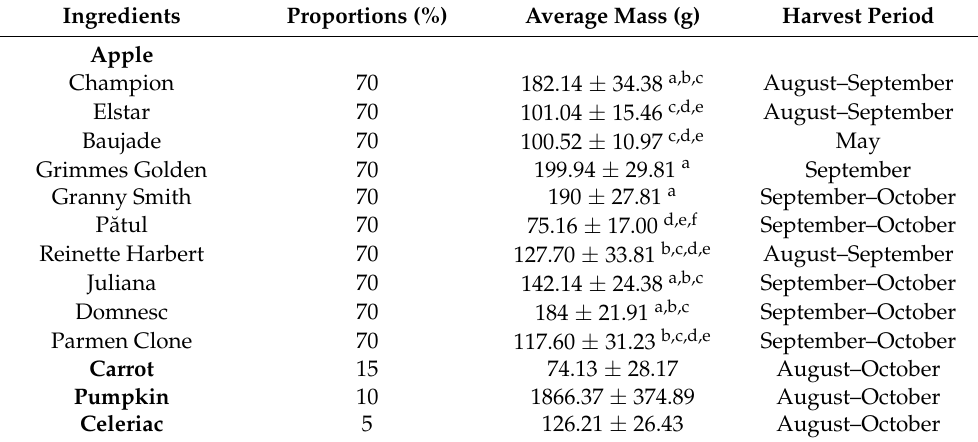
Table 1. Details regarding raw materials and proportions used to obtain purees for children.